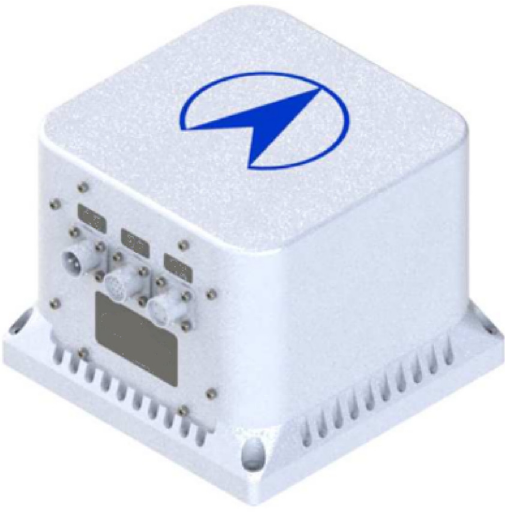
Figure 6. FSINS3X. Figure 6. FSINS3X. Table 2. Main technical parameters of a FSINS3X inertial navigation Table 2. Main technical parameters of a FSINS3X inertial navigation system.